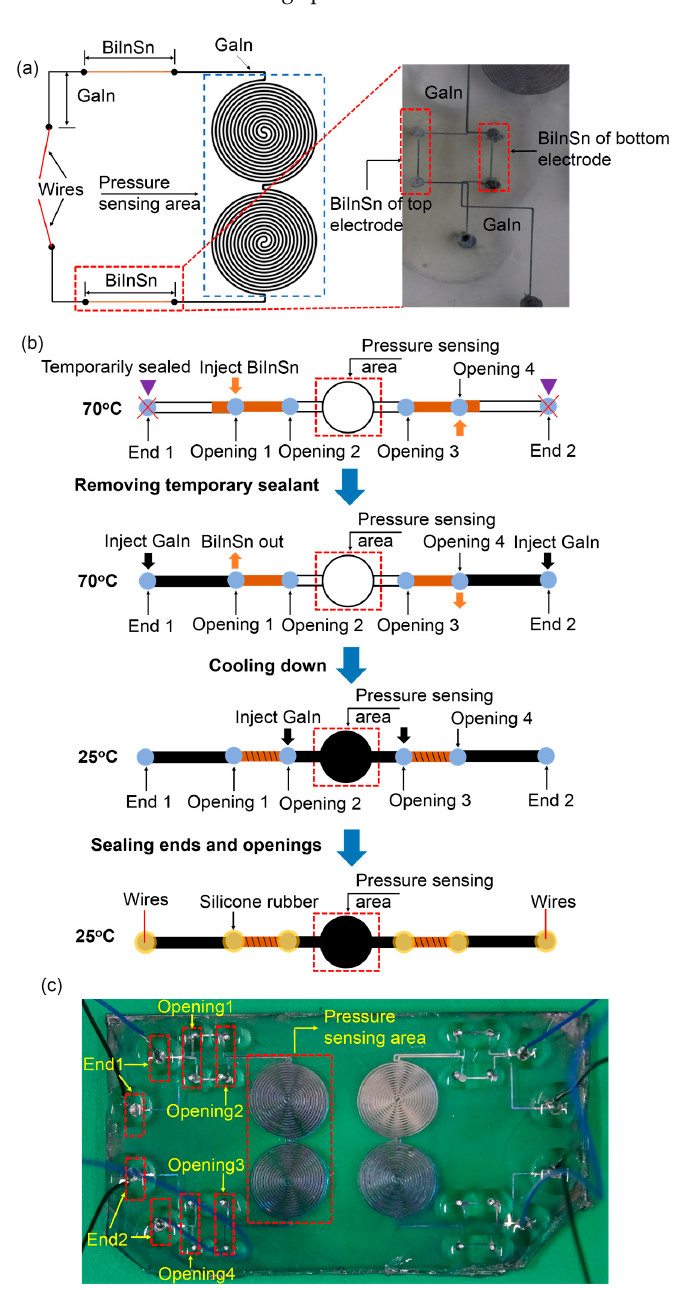
Figure 4. ( a ) Structure of the GaIn-BiInSn leakage-free electrode; ( b ) fabrication process of the leakage-free electrode; ( c ) fabricated stretchable capacitive sensor with the leakage-free electrode.